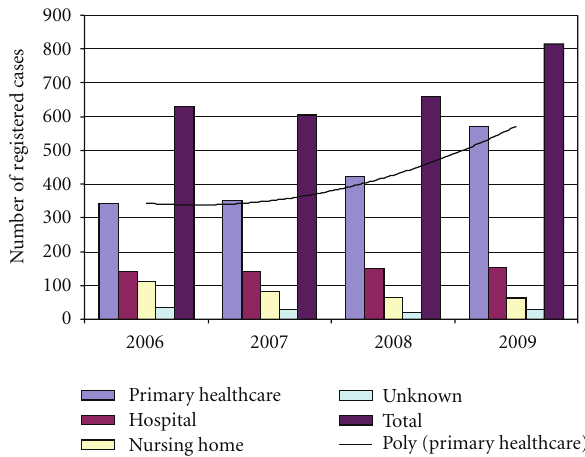
Figure 1: Development of MRSA (all cases) in Norway 2006–2009.